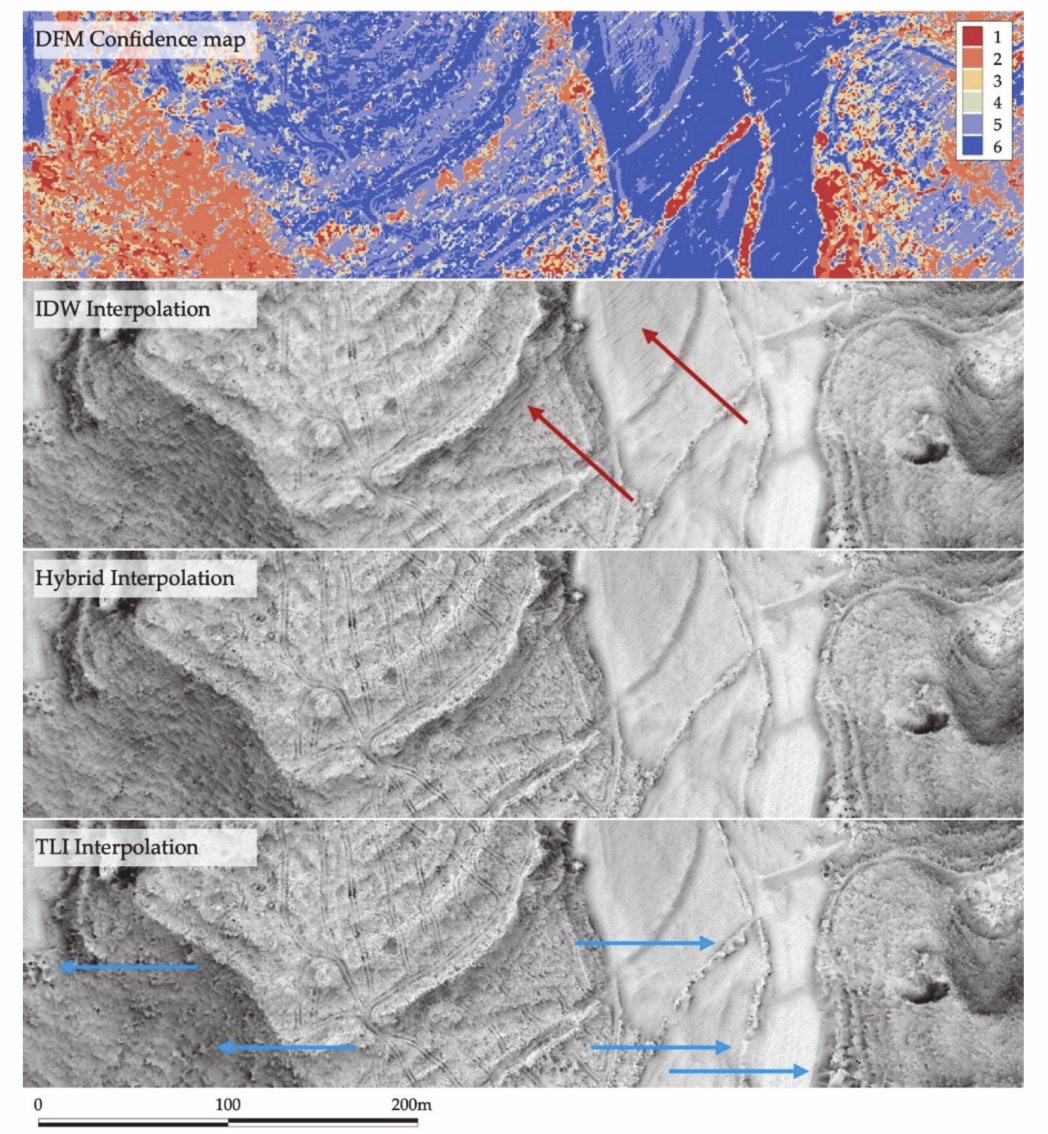
Figure 9. Test site SI1, hybrid interpolator compared to DFM confidence map, IDW, and TLI. Specific IDW (red arrows) and TLI (blue arrows) artifacts are not present in the hybrid interpolation. DFM processing: IDW and TLI calculated with default settings in Golden Software Surfer 19.2.x, other processing steps as in Table